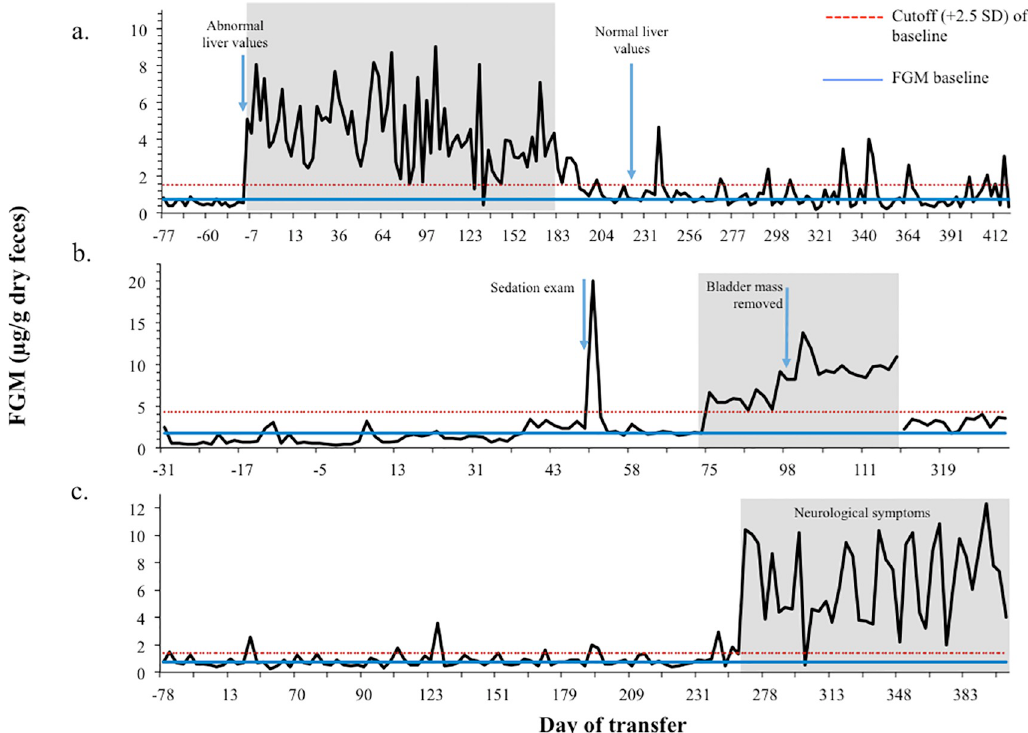
Fig 4. Elevations in fecal glucocorticoid metabolite (FGM) due to chronic illness. Sustained periods of elevation in FGMconcentrations were observed during chronic illness in three fishing cats: (a) SB# 780 presented with elevated liver values during his exam for pre-shipment and was later diagnosed and treated for hepatitis with normal liver values reported 212 days post transfer; (b) SB# 657 treated for a bladder mass tumor, and although collection ended while values were still